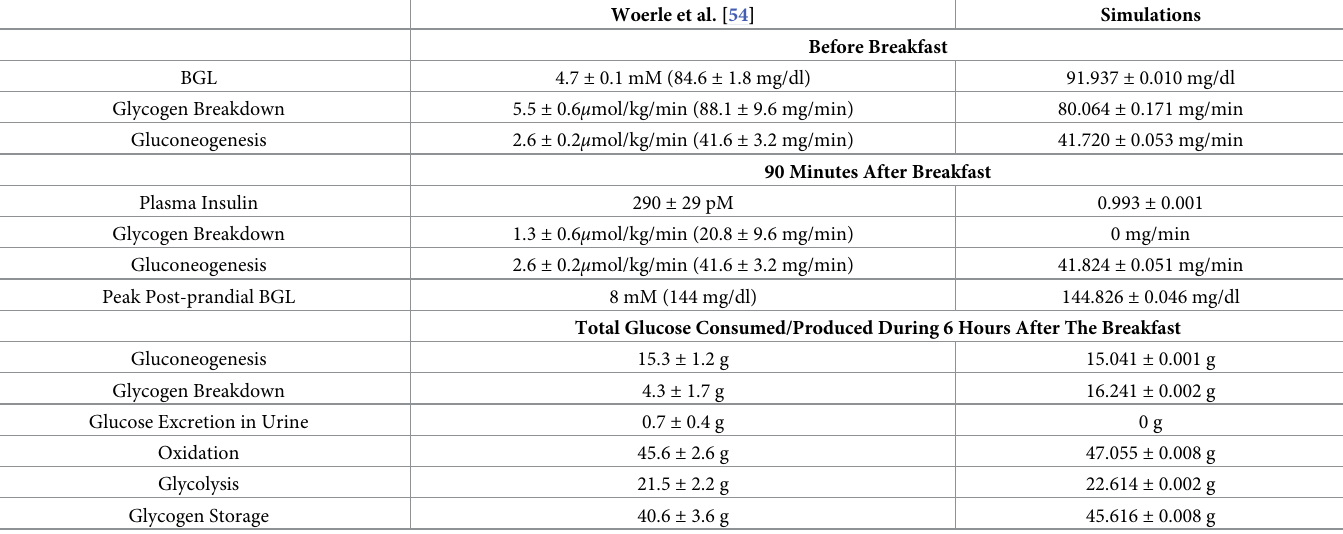
Table 4. Normal Subjects: Key measurements from Woerle Et Al. [54] and corresponding results from 30 simulations with different seeds. “Before Breakfast” Simula- tion Results Were Observed at 9.59AM. All Values Expressed as Mean ± Std Error . Woerle et al. [54]